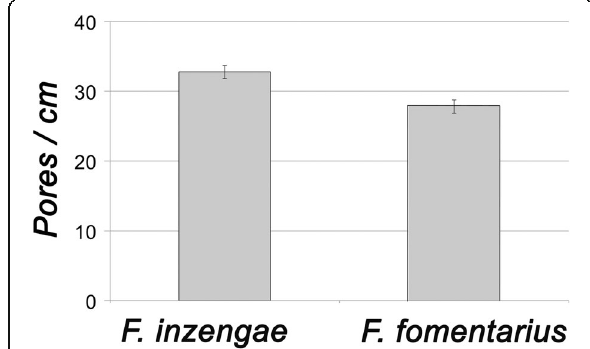
Fig. 2 Comparison of pore diameter (as pores / cm hymenophore surface) of Fomes inzengae and F. fomentarius . Pore diameter is significantly different ( p = 0.000027, n =